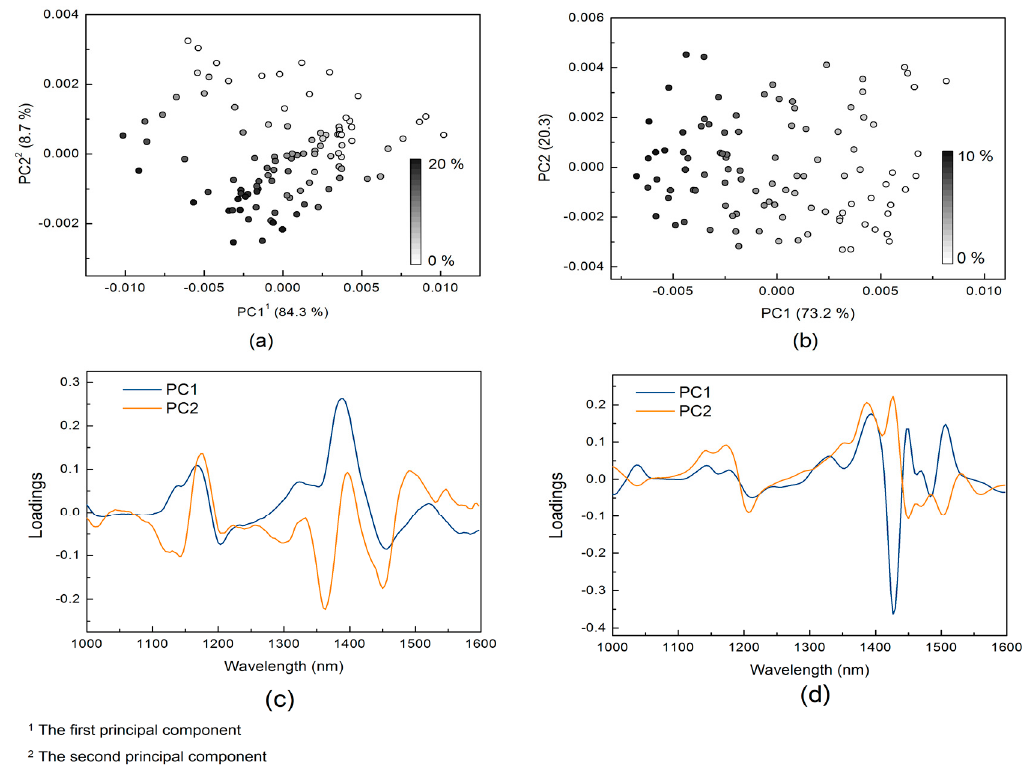
Figure 2. Principal component analysis score plots and loading curves of the infant formula adulteration data sets: ( a ) score plot of the hydrolyzed leather protein (HLP) data set; ( b ) score plot of the melamine data set; ( c ) loading curve of the HLP data set; ( d ) loading curve of the melamine data set.